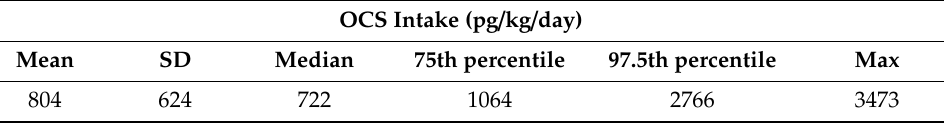
Table 6. Estimation of OCS intake among breastfed infants (1 year